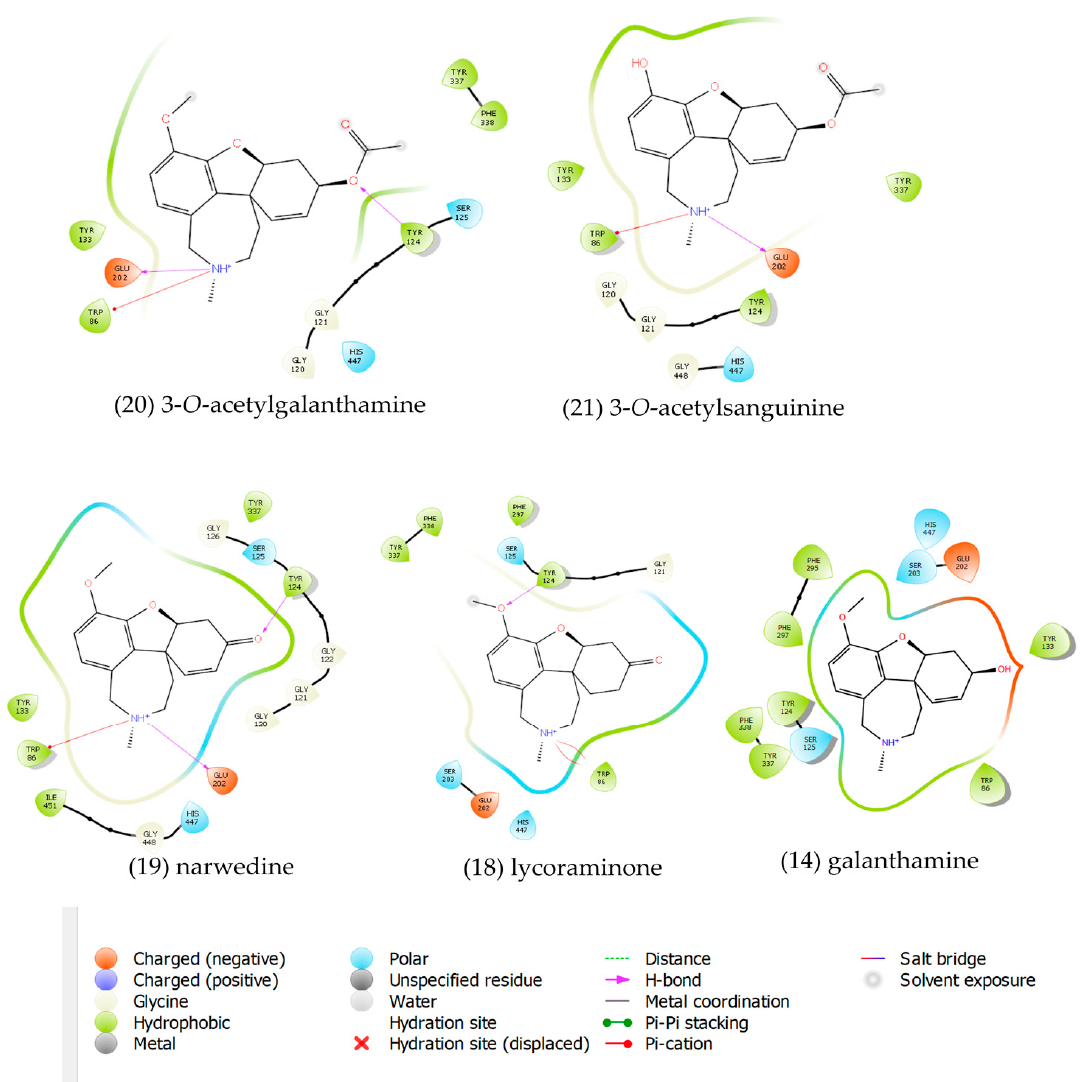
Figure 5. 2D ligand–4EY6 protein interaction diagram for 3- O -acetylgalanthamine ( 20 ), 3- O -acetyl- sanguinine ( 21 ), narwedine ( 19 ), lycoraminone ( 18 ), and galanthamine ( 14 ).